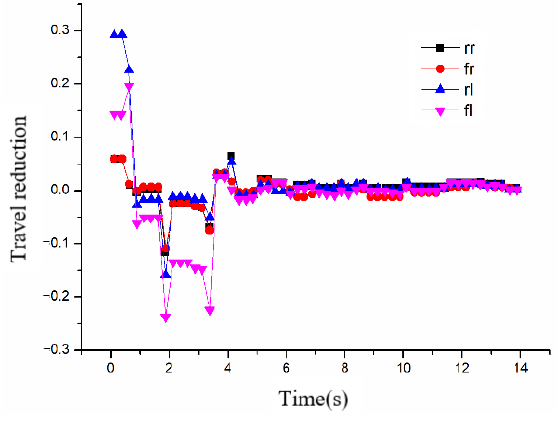
Figure 11. Travel reduction of SMC.